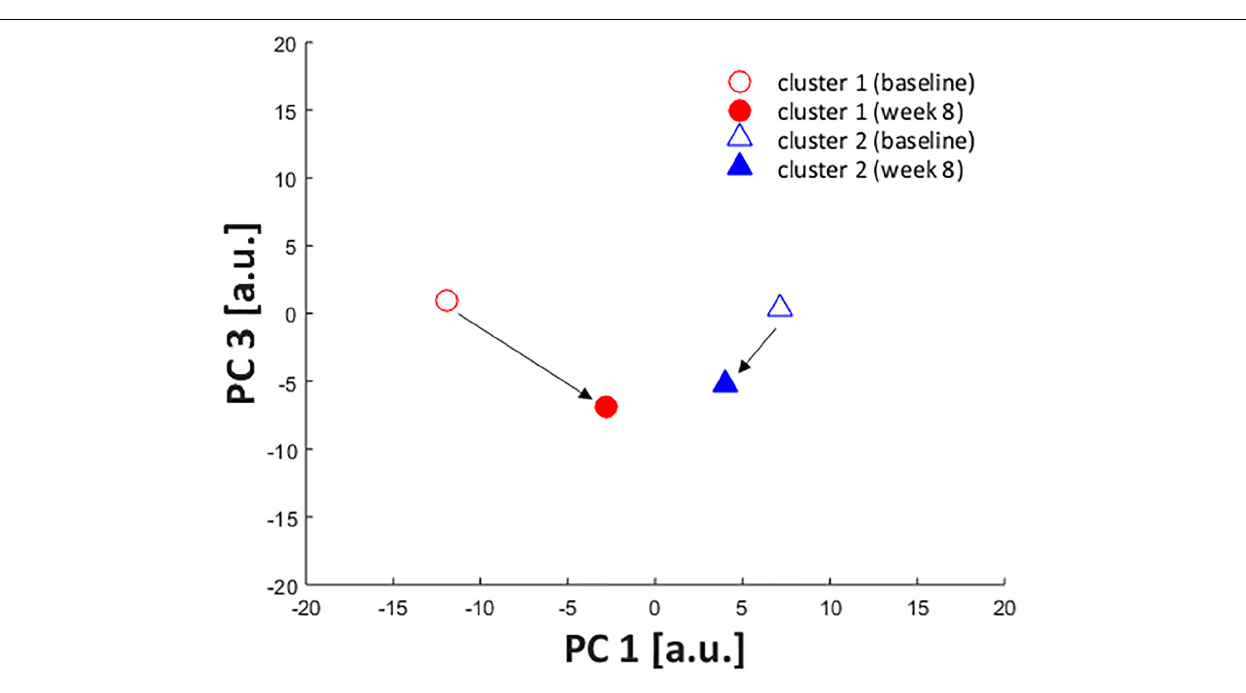
FIGURE 9 | Scatterplot showing PC1 and PC3 scores of cluster centroids at baseline (open) and week 8 (filled) assessments. The centroid of cluster 1 is represented by red circles and cluster 2, by blue